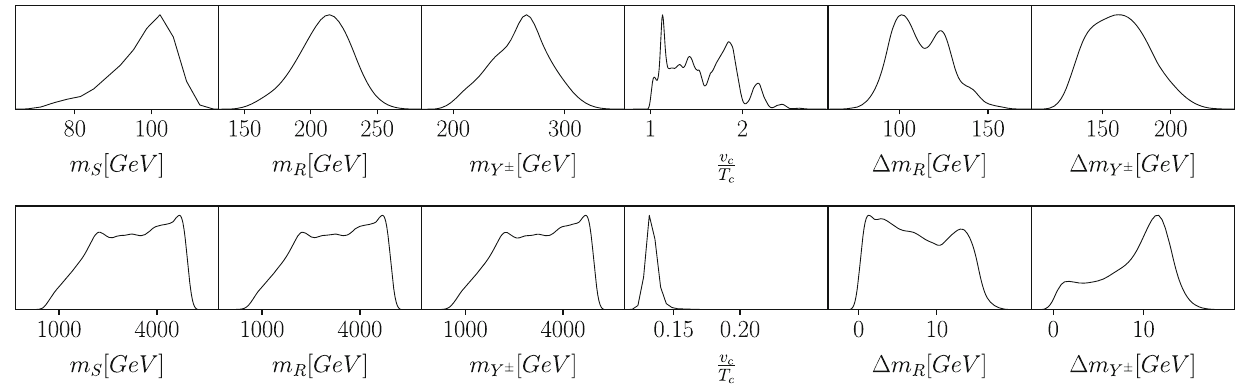
> 1. The last two plots present the posteriors of first-order EWPT, v c T c the mass splittings between the inert scalars, (cid:2) m R = m R − m S and (cid:2) m = m − m S . The second row of plots is the same as the first, Y ± Y ± but without v c